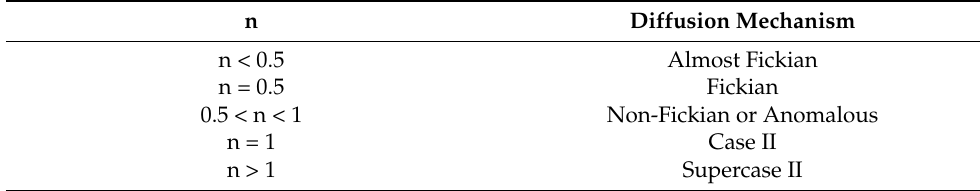
Table 1. Diffusion Mechanism